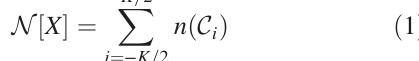
FIG. 1. Relaxation time and configurational entropy of the Kob-Andersen mixture. (a) The relaxation time (black circles) strongly increases as a function of inverse temperature. This is fitted with the Vogel-Fulcher-Tamman expression ln τ α ∝ ð T − T (arrow). Along with the relaxation time, the average population h n i of LFS (red squares, see inset for a which we take to diverge at T K rendering of the structure) increases upon cooling. The red line is an empirical two-parameter fit to Eq. (2). (b) The probability distribution of the inherent state energy ϕ is Gaussian (dashed line, shown for sampling temperature T configurational entropy s ð ϕ Þ for three different sampling temperatures and fitted by a quadratic form (continuous line) down to very low ≃ − 7 . 82 at which the entropy would vanish is obtained from an extrapolation. In the inset, we use ϕ energies. The energy ϕ K ≈ 0 . 30 by extrapolating molecular dynamics results (black estimate T K